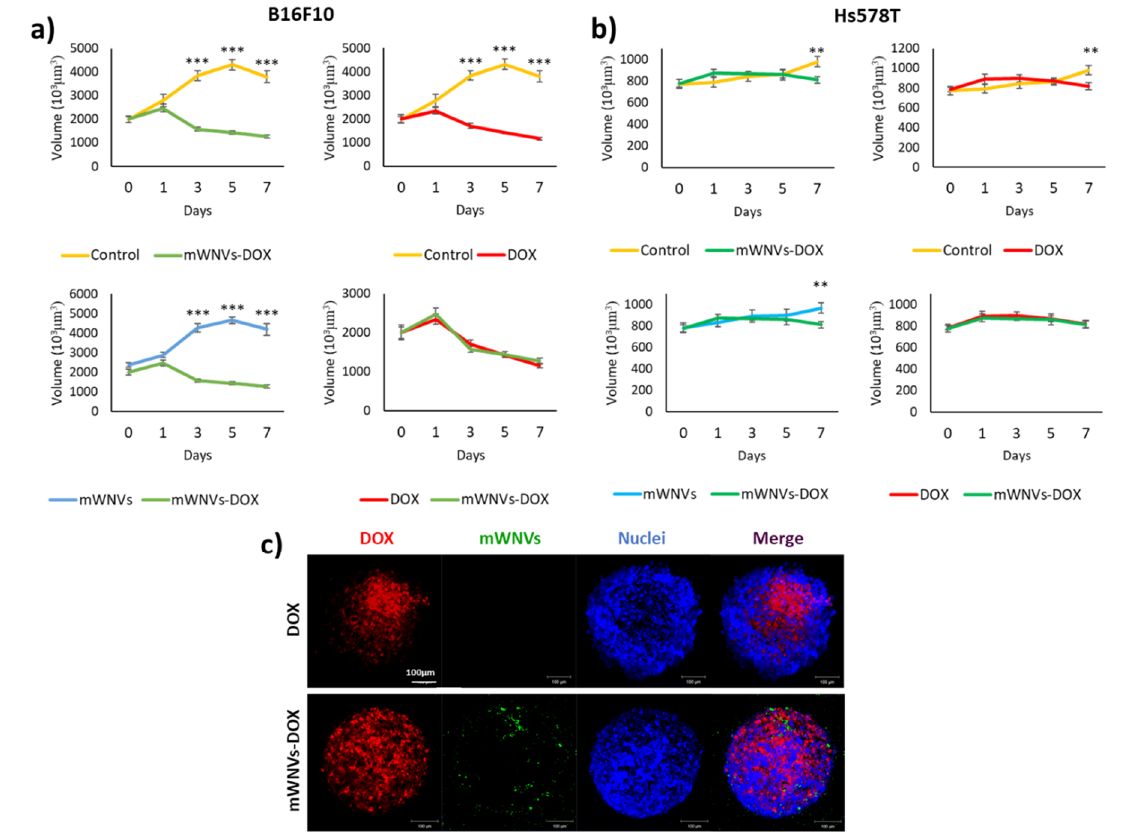
Figure 5. Volume evolution of ( a ) B16F10 MCTSs and ( b ) Hs578T MCTSs treated with DOX (red), control unloaded mWNVs (blue) and mWNV-DOX (green) measured for 7 days (mean ± SEM; ** p < 0.005, *** p < 0.001, Student’s t -test). ( c ) Confocal microscopy images of B16F10 MCTSs treated with DOX (top row) and mWNV-DOX (bottom row).